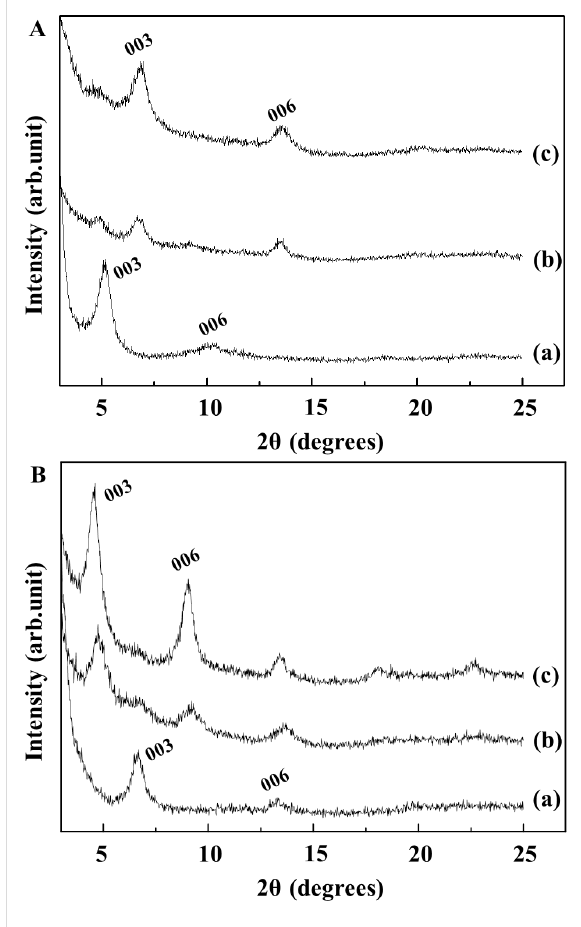
Figure 7: X-ray diffraction (XRD) patterns of GL hybrids obtained by interconverting interlayer GMP arrangement. (a): GL-R to GL-S and (b): GL-S to GL-R, for starting (line a), intermediate (line b) and final (line c) products.